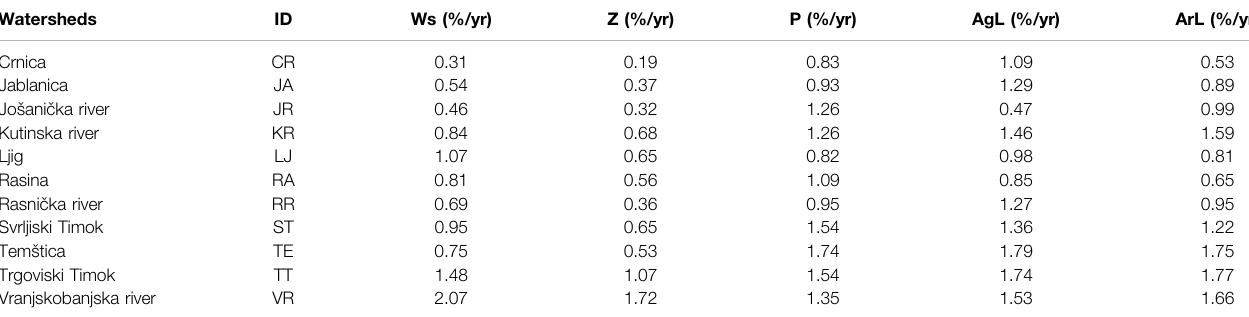
TABLE 12 | Rates of the reduction of erosion, rural population, agricultural land and arable land. Watersheds